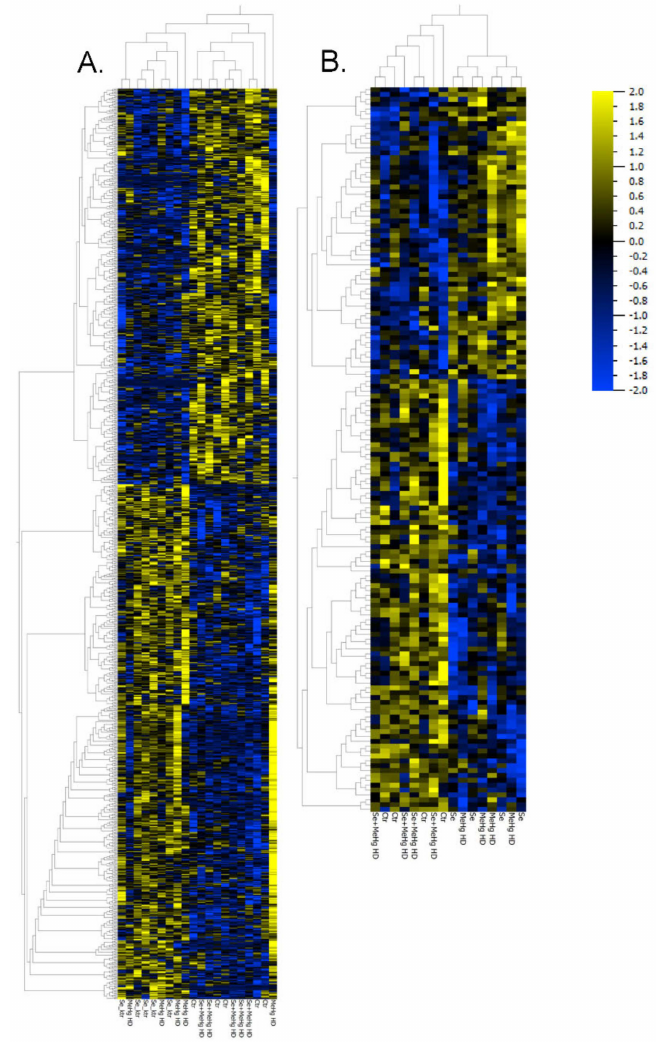
Figure 3. Heatmaps and hierarchical clustering analysis (HCA) displaying significant MeHg HD- SeMet interaction effect in 916 RNA transcripts ( p < 0.05) ( A ) and in 149 proteins ( p < 0.05) ( B ) (ANOVA, hierarchical clustering, Pearson